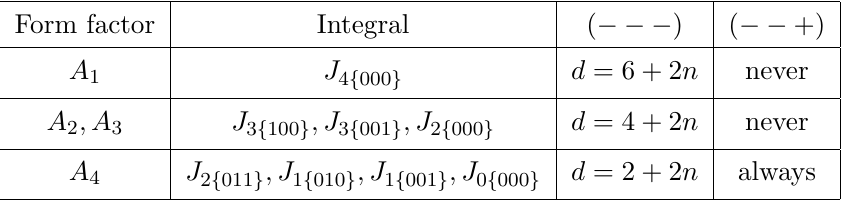
J (cid:22) 2 J (cid:22) 3 i . 1 (cid:23) 1